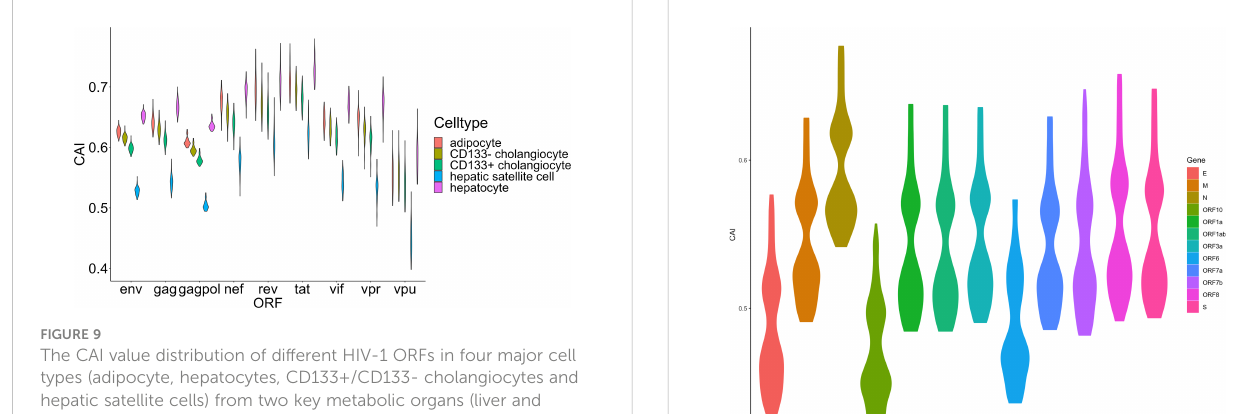
FIGURE 9 The CAI value distribution of different HIV-1 ORFs in four major cell types (adipocyte, hepatocytes, CD133+/CD133- cholangiocytes and hepatic satellite cells) from two key metabolic organs (liver and adipose tissue) from bulk RNA-seq datasets shown by violin plot. Each violin shows the CAI value distribution of a speci fi c HIV-1 ORF in a speci fi c cell type.